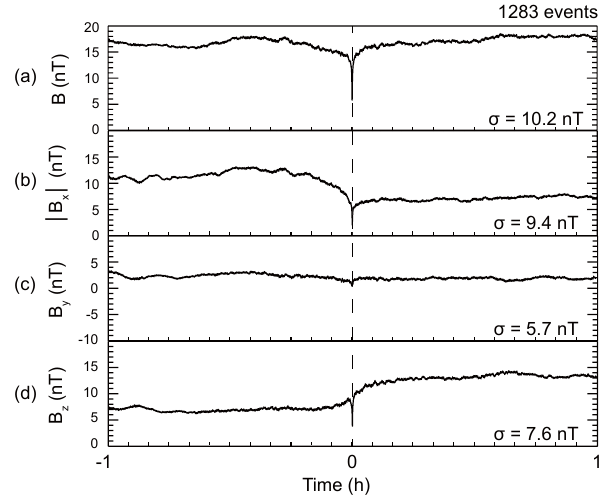
Figure 10. Superposed epoch analysis of magnetic field intensity variations 1h before and after the time of severe magnetic fluctua- tion